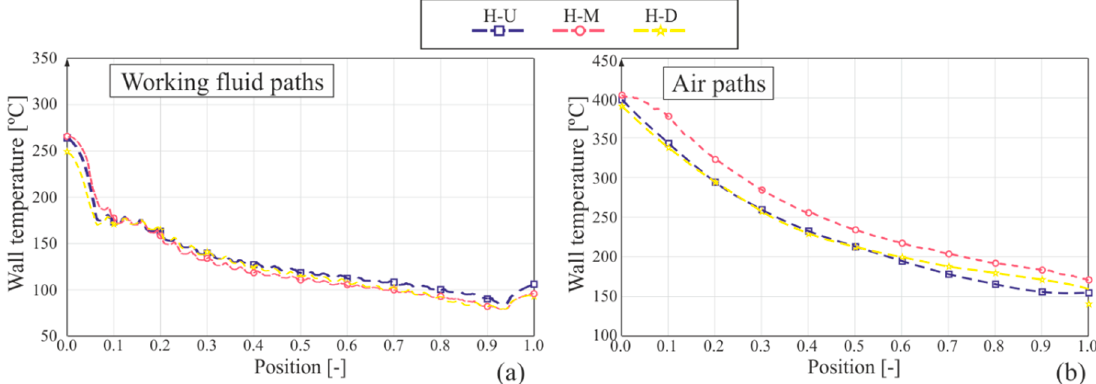
Figure 11. Graphs of horizontal temperature profile: ( a ) working fluid (WF) paths and ( b ) in the air.